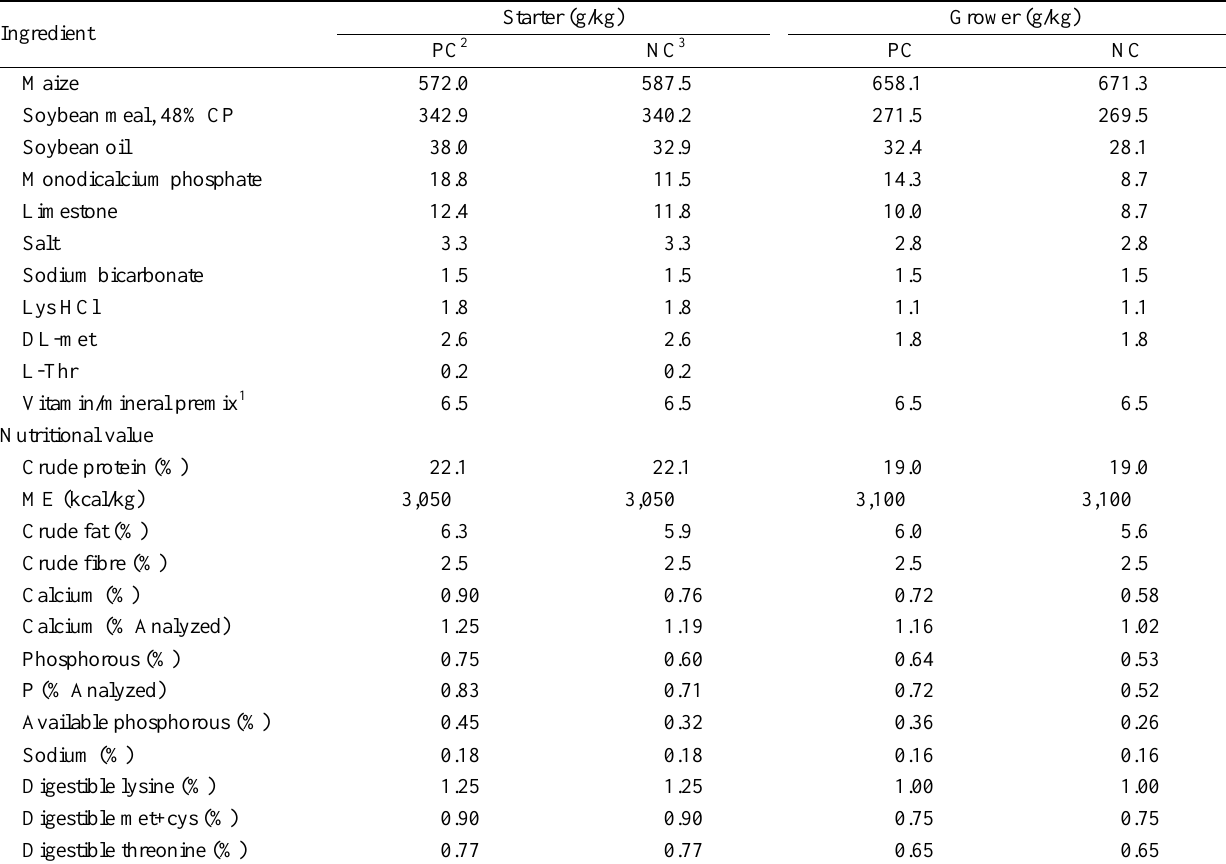
Table 1. Ingredient and nutrient composition of experimental